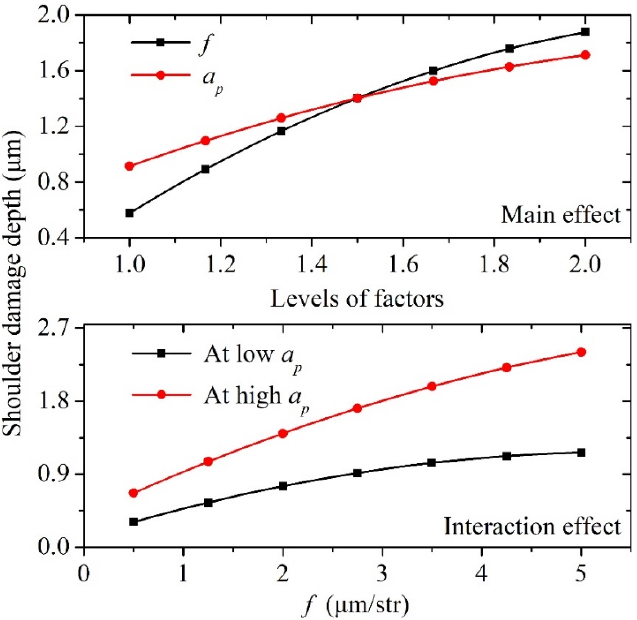
Figure 6. Effects of cutting parameters (feed f , cutting depth a p ) on shoulder damage